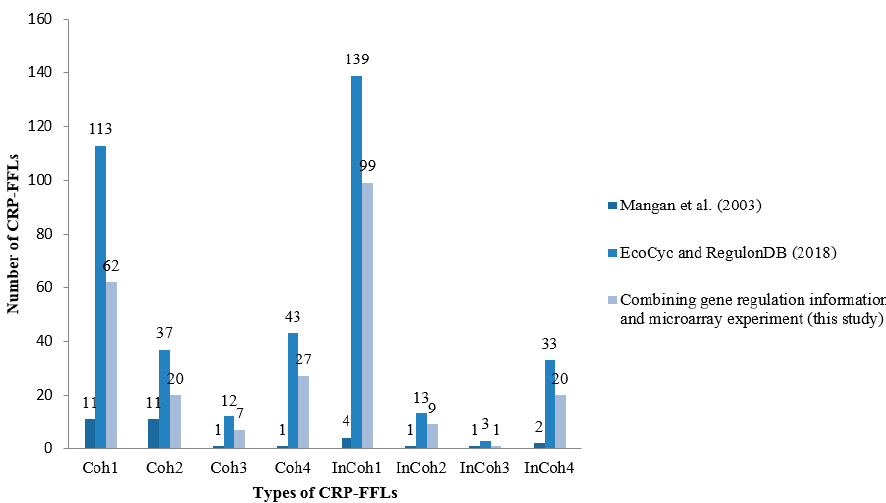
Figure 3. Distribution of CRP-FFLs in E. coli . Regulation information was based on the statistics obtained from Mangan et al. (2003) [10], EcoCyc and RegulonDB and CRP-FFLs generated in this study. Some CRP-regulated genes reported in the literature and public databases did not show significant differential expression in our experimental conditions, probably because these genes require other TFs that are only expressed in specific conditions for a cooperative response to cAMP.